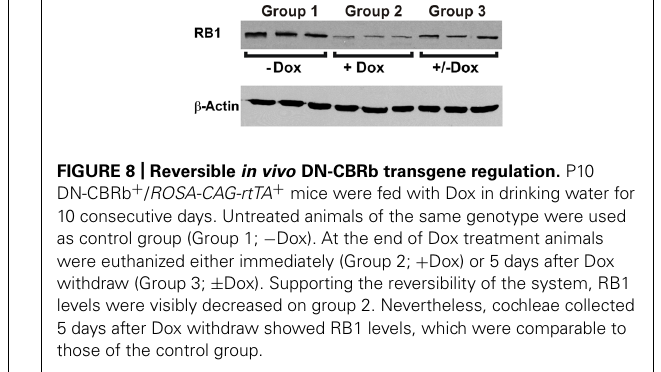
translated into active proteins. Noteworthy, mosaic transgene